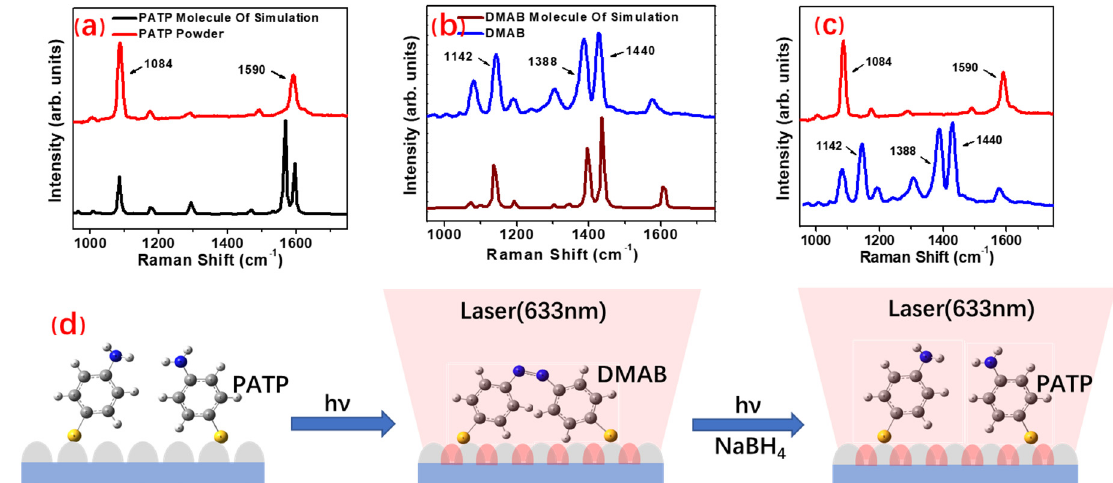
Figure 1. The photocatalytic formation process of DMAB from PATP surface plasma driven: ( a ) PATP Raman characteristic peaks; ( b ) DMAB Raman characteristic peaks; ( c ) comparison of Raman spectra of PATP and DMAB; and ( d ) the schematic diagram of the plasma driven photocatalytic reaction.